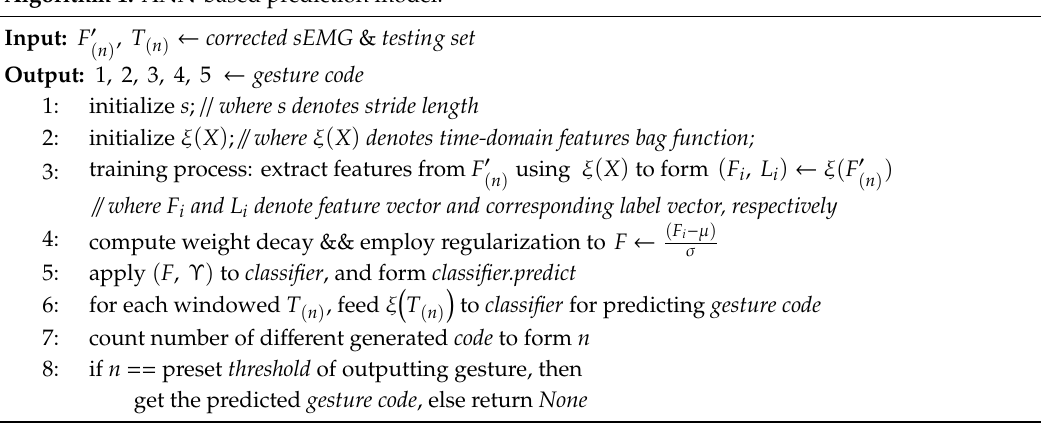
Algorithm 1. ANN-based prediction